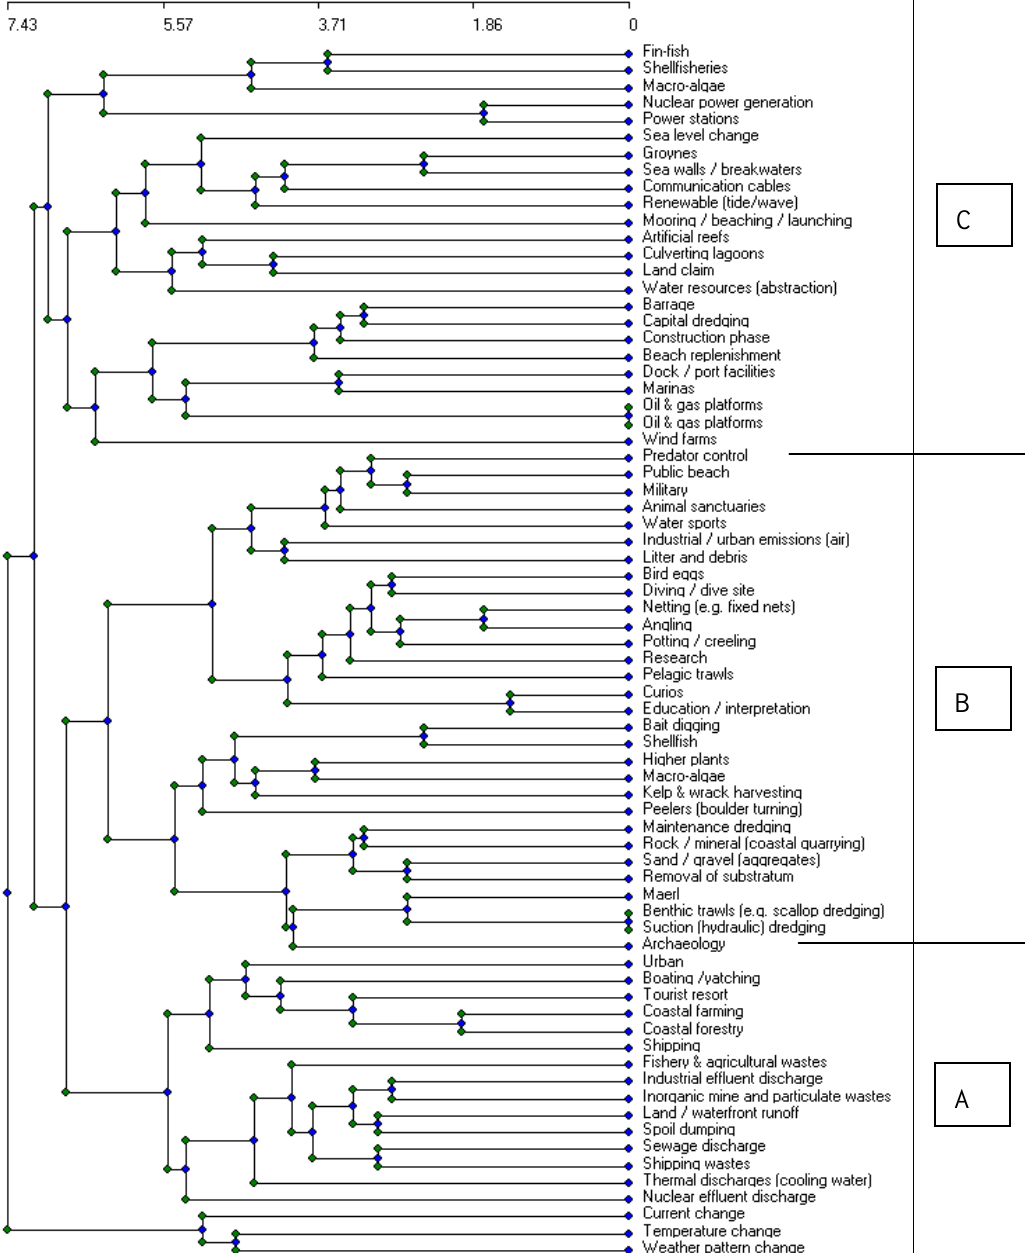
Figure 1. Example of cluster analysis of comparison matrix, analysing waste activities, biological extraction and physical structures (A. waste discharges and waste activities; B. biological and physical extraction and activities; C. physical structures and physical